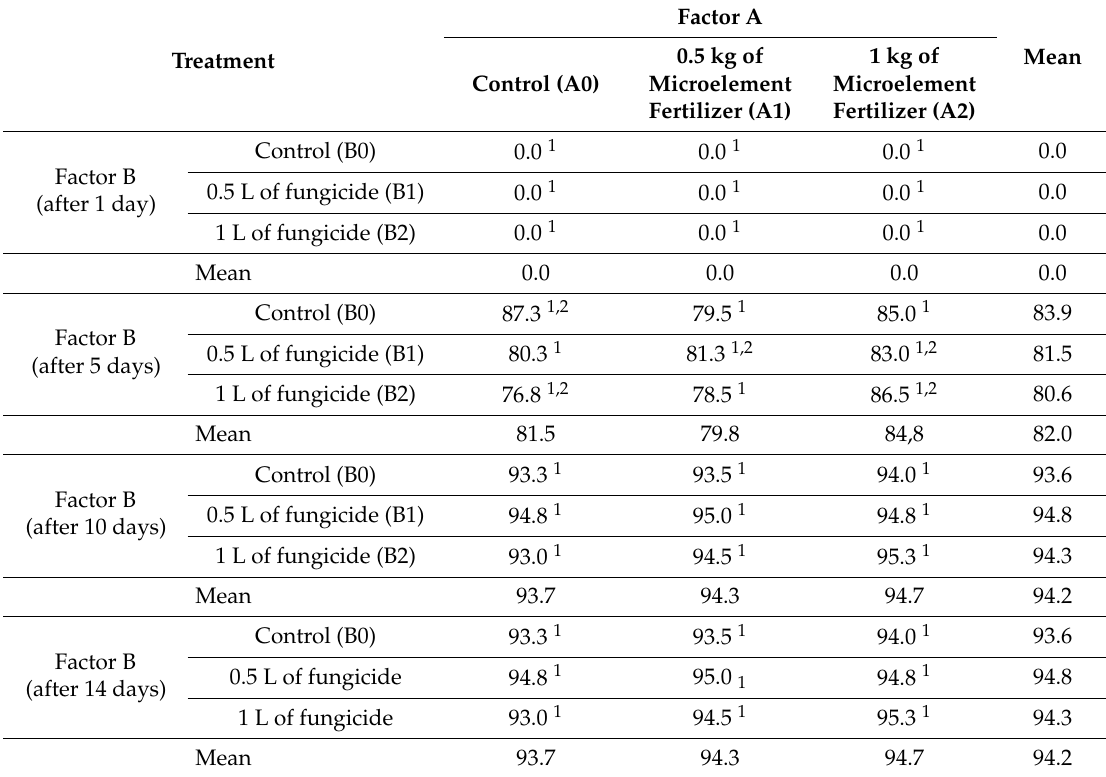
Table 4. E ff ect of the micronutrient fertilizer and fungicide on the number of germinated seeds after a given number of